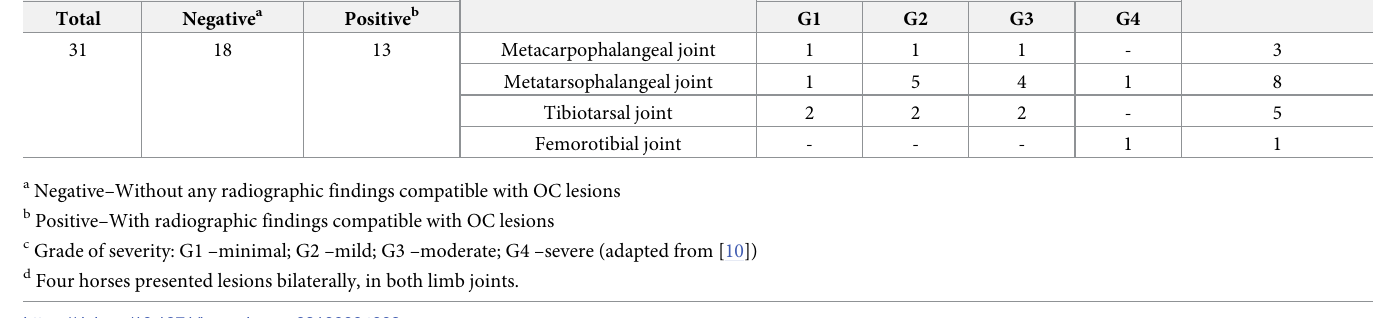
Table 2. Radiographic status and radiographic findings by site in 31 Lusitano horses. Number of